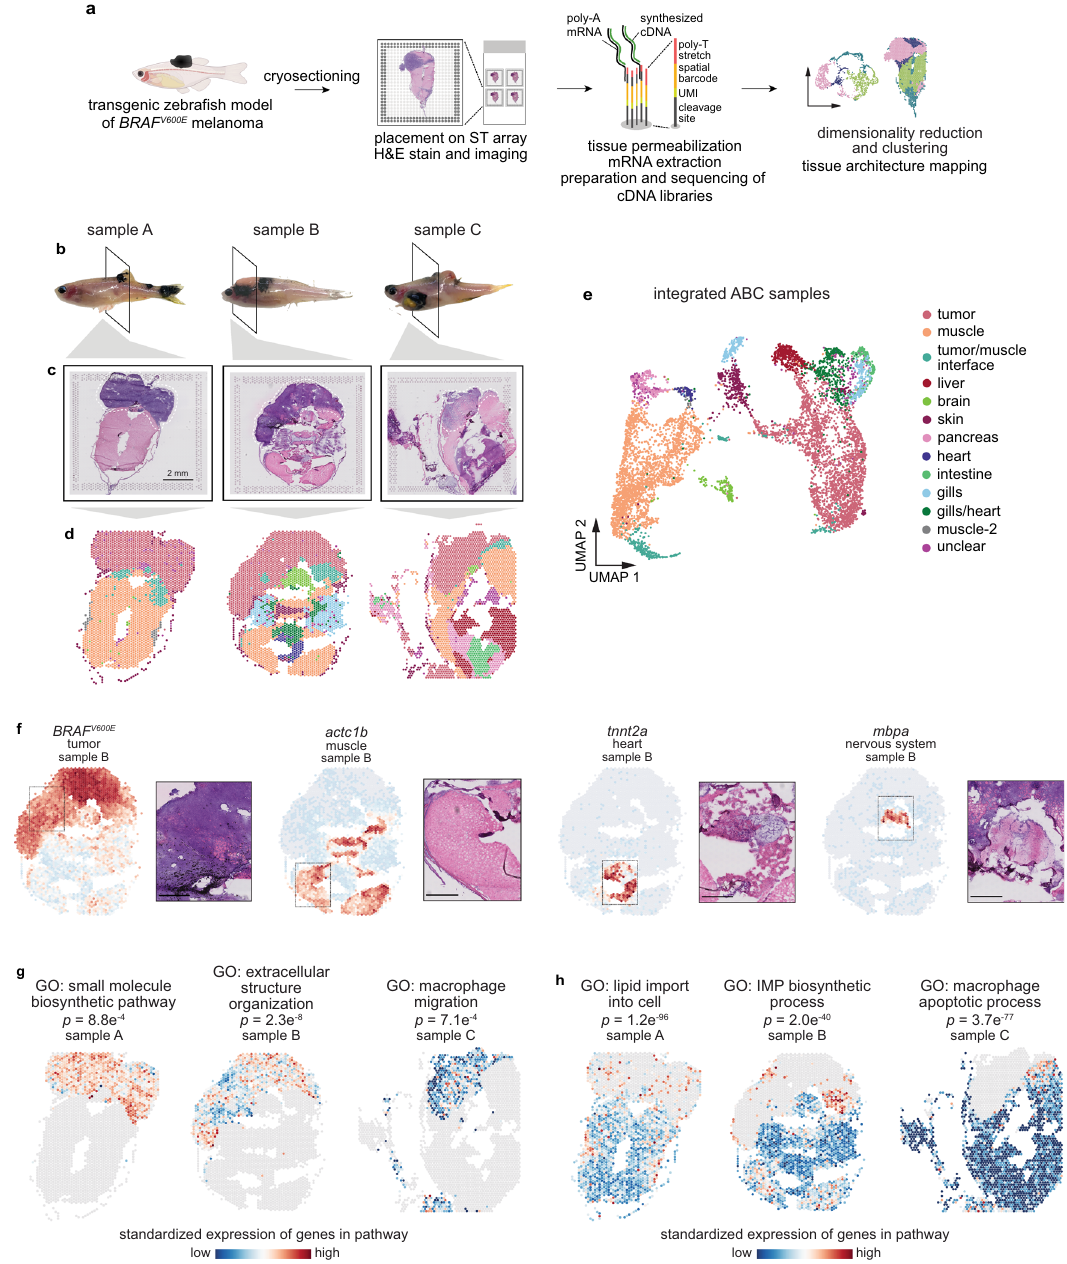
Fig. 1 Spatially resolved transcriptomics reveals the transcriptional architecture of melanoma and its surrounding microenvironment. a Schematic showing the spatially resolved transcriptomics (SRT) experiment work fl ow. b Images of zebra fi sh with BRAF V600E -driven melanomas used for SRT. The region where the fi sh were sectioned is highlighted. Scale bar, 2 mm. c H&E staining of cryosections used for SRT ( n = 3 sections). d Visium array spots colored by clustering assignments of the integrated dataset (see “ Methods ” section). e UMAP embedding of SRT spots from all three samples colored by cluster assignments of the integrated dataset (see “ Methods ” section). f The expression of select marker genes ( BRAF V600E , tumor; pvalb4 , muscle; kcn6a , heart; mbpa , nervous system) from the SRT data projected over tissue space (left), with images of the corresponding histology from the indicated region of the SRT array (right). Scale bar, 500 µ m. g , h Average, standardized expression of annotated genes for gene ontology (GO) terms displaying spatially- coherent expression patterns in the tumor ( g ) and microenvironment ( h ) regions in each sample. p -values represent the comparison between the distance between spots expressing that GO term genes and a null-distribution of distances between random spots (Wilcoxon ’ s Rank Sum test,